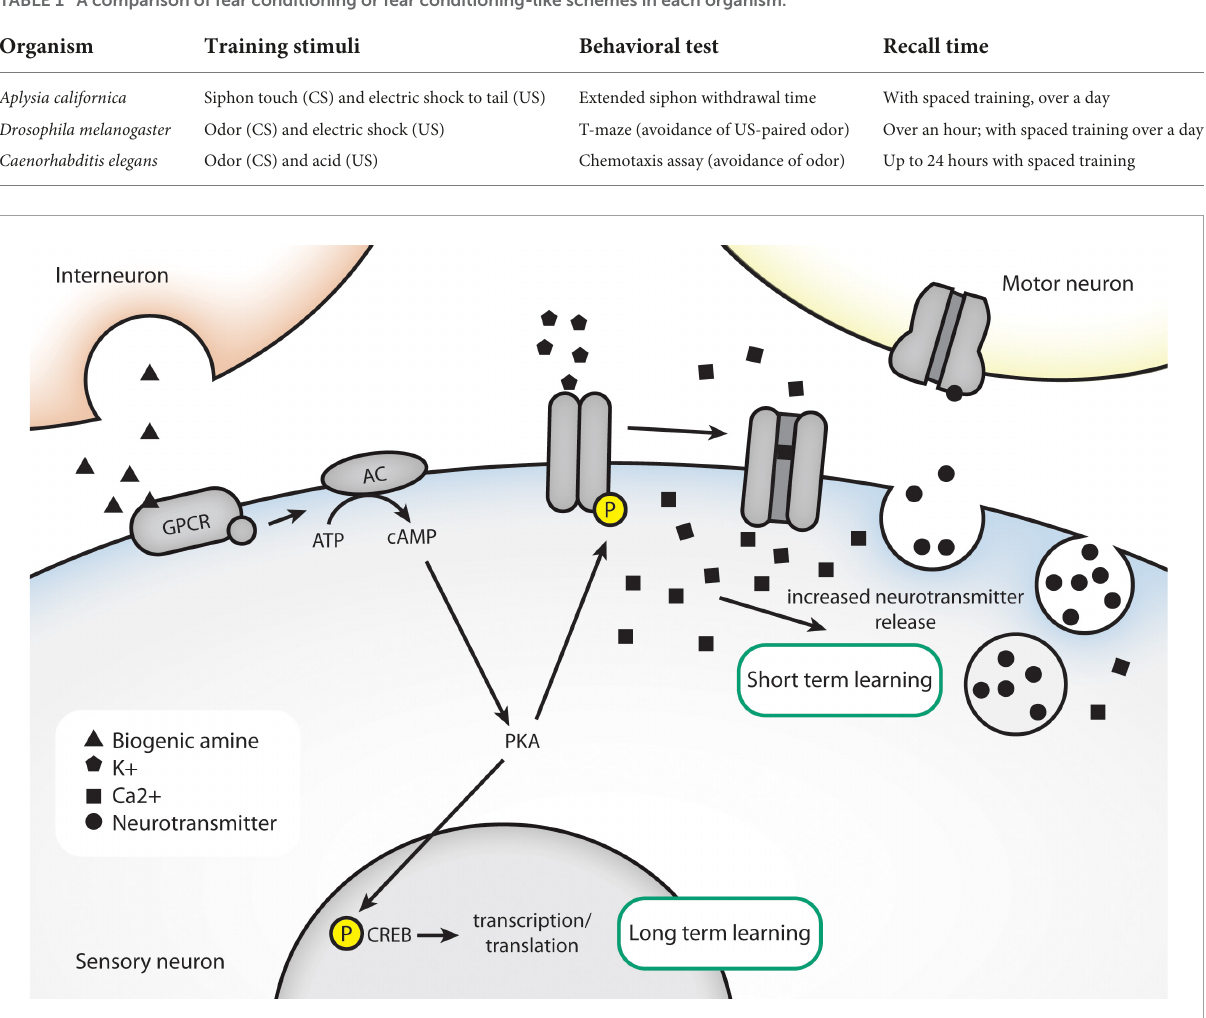
FIGURE2 Conserved molecules in associative learning, as identified in invertebrate models. An unconditioned stimulus, like electric shock, causes release of dopamine/serotonin. The presence of a conditioned stimulus causes postsynaptic calcium levels to rise through closing of K+ channels. High intracellular calcium results in increased release of neurotransmitter. Long-term behavioral changes can be effected through altered transcription via nuclear translocation of